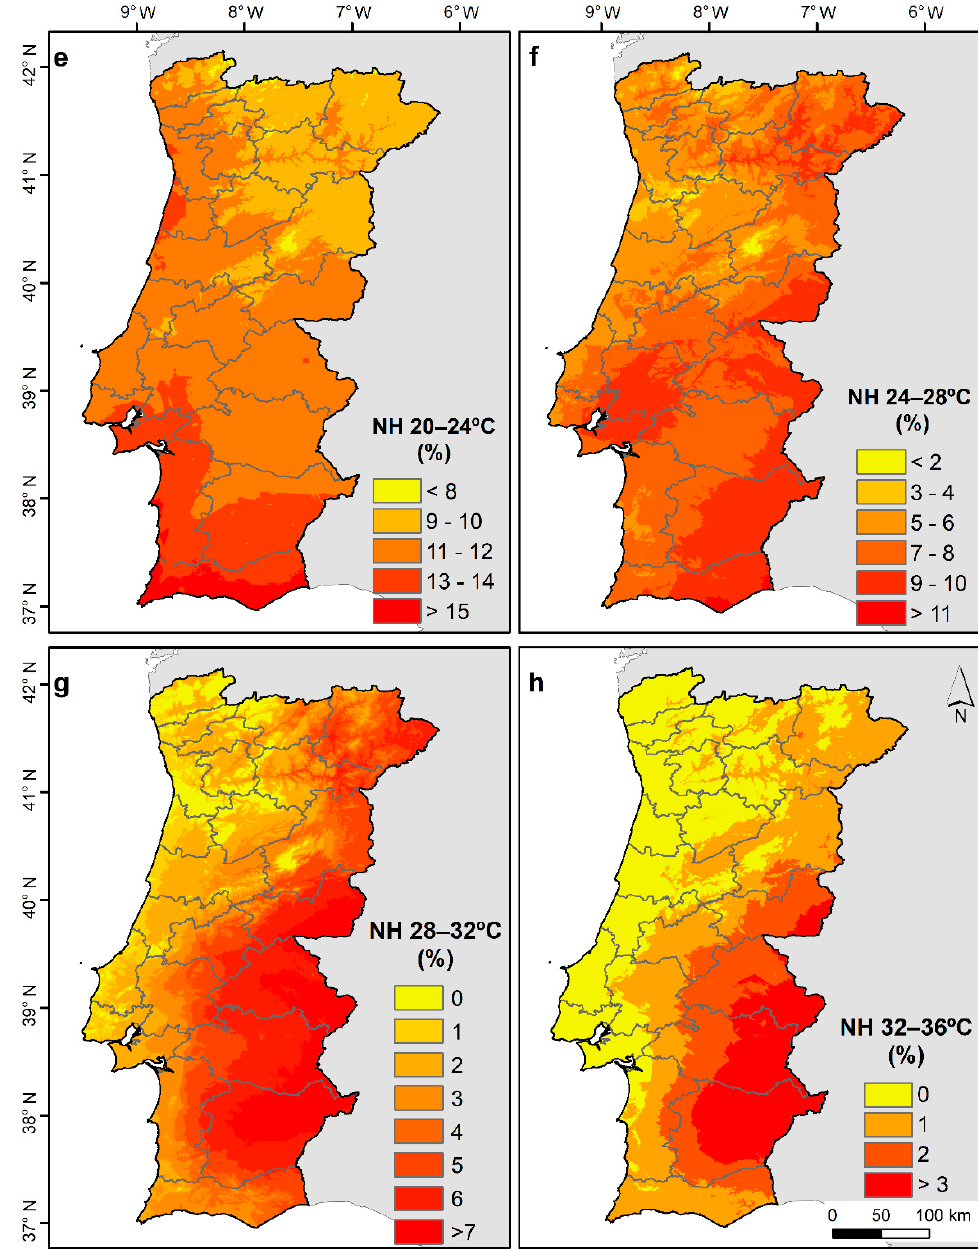
Figure 4. Relative number of hours in the year (in %) by different temperature intervals: ( a ) 4–8 °C, mainland Portugal, for the period of 2000–2018 after applying the geostatistical interpolation (cf. Figure 1b for designations of mapped NUTS level 3).